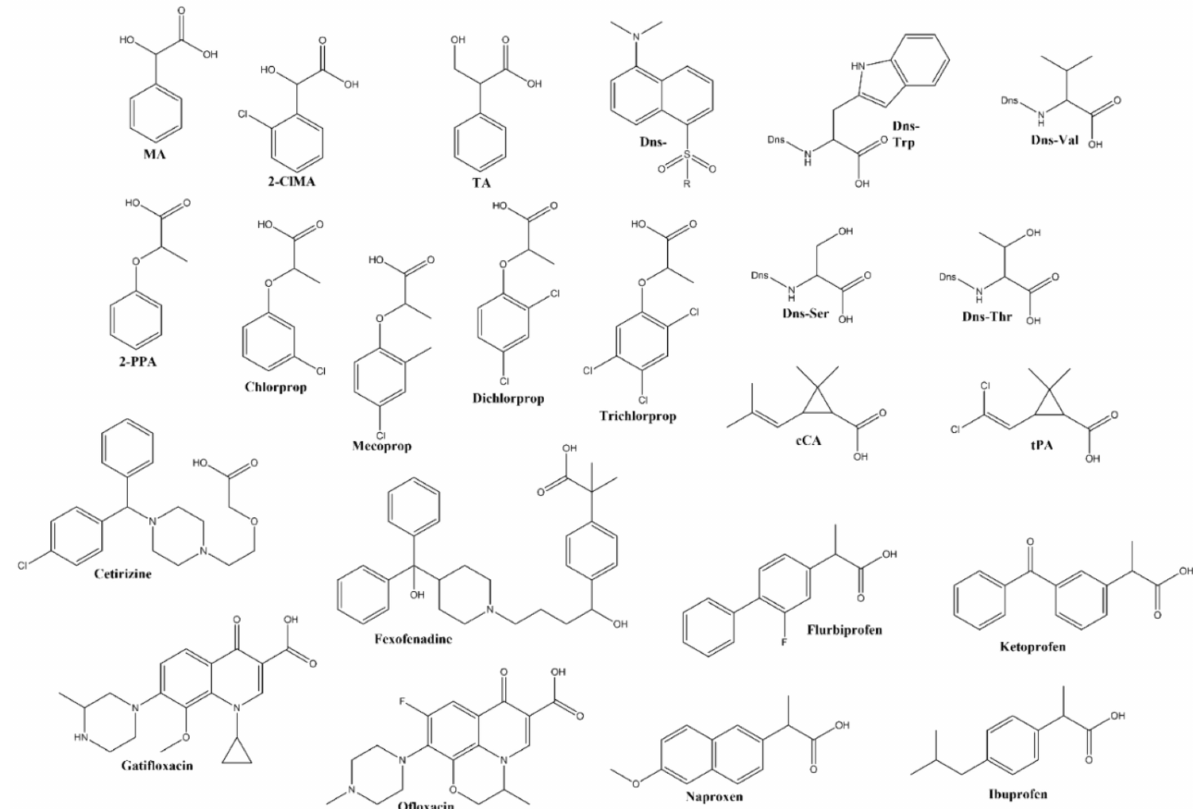
Figure 2. Chemical structures of the test analytes. Organic acids [mandelic acid (MA), 2-chloromandelic acid (2-ClMA), tropic acid (TA), cis-chrysanthemic acid (cCA) and trans-permetrinic acid (tPA)], pesticides [2-phenoxypropionic acid (2-PPA) 2-(3-chlorophenoxy)propionic acid (chlorprop), 2-(2,4-dichlorophenoxy)propanoic acid (dichlorprop), 2-(4-chloro-2- methylphenoxy)propionic acid (mecoprop), 2-(2,4,5-trichlorophenoxy)propionic acid (trichlorprop)], Dns-AAs (Dns-Ser, Dns-Thr, Dns-Trp, Dns-Val), NSAIDs (flurbiprofen, ibuprofen, ketoprofen, naproxen) antihistamines (cetirizine, fexofena- dine) and fluoroquinolone antibiotics (gatifloxacin,